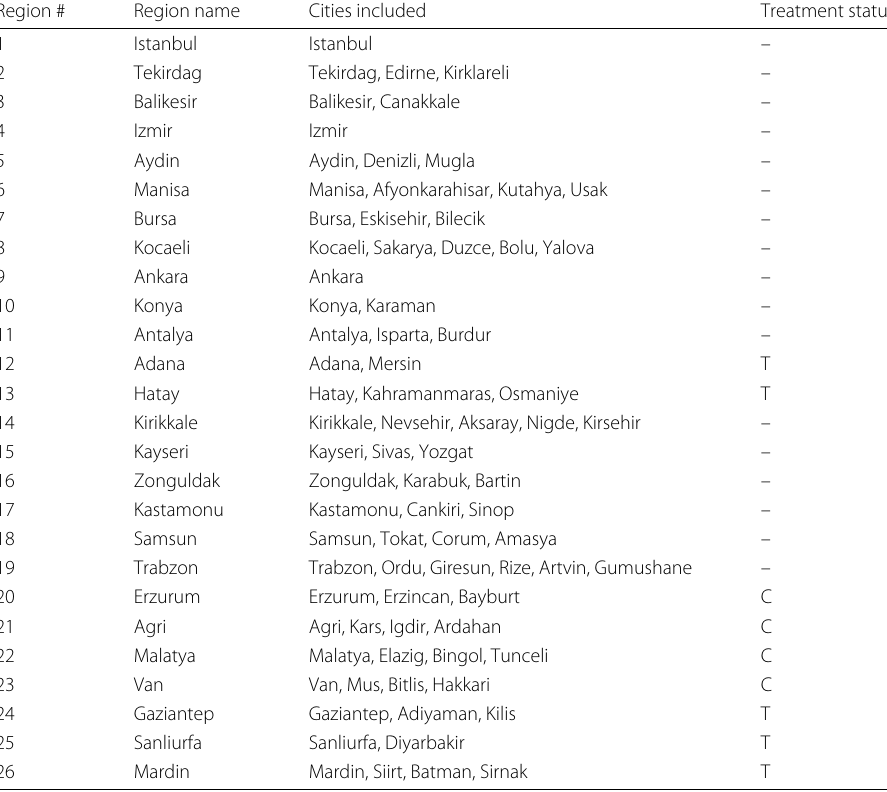
Table 16 NUTS2-level regional division in Turkey Region